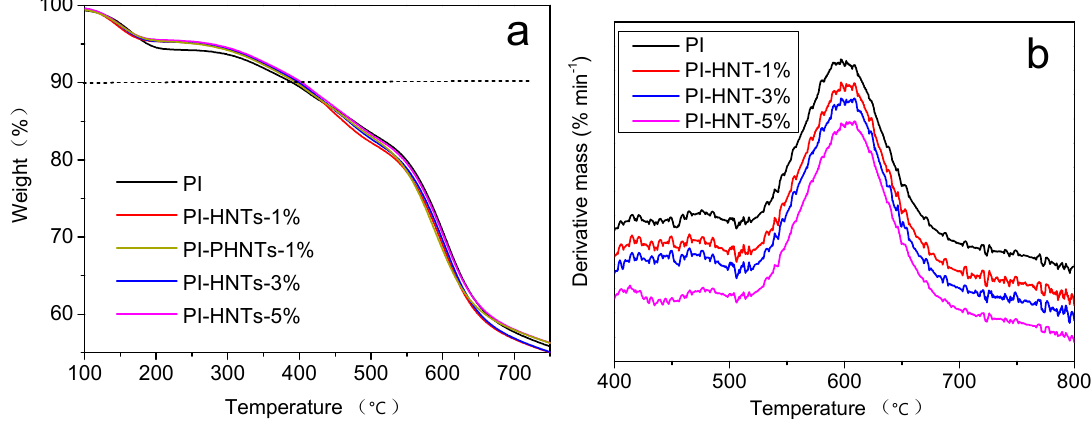
Figure 8. TGA ( a ) and DTG ( b ) curves of PI, PI-HNTs-1%, PI-HNTs-3%, and PI-HNTs-5%. Table 2. The decomposition temperatures of the samples at 10 wt% loss. Samples